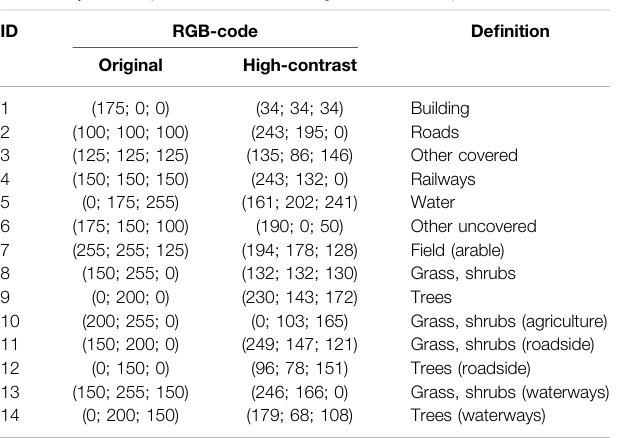
TABLE 1 | Summary of the colours of the ground cover map.